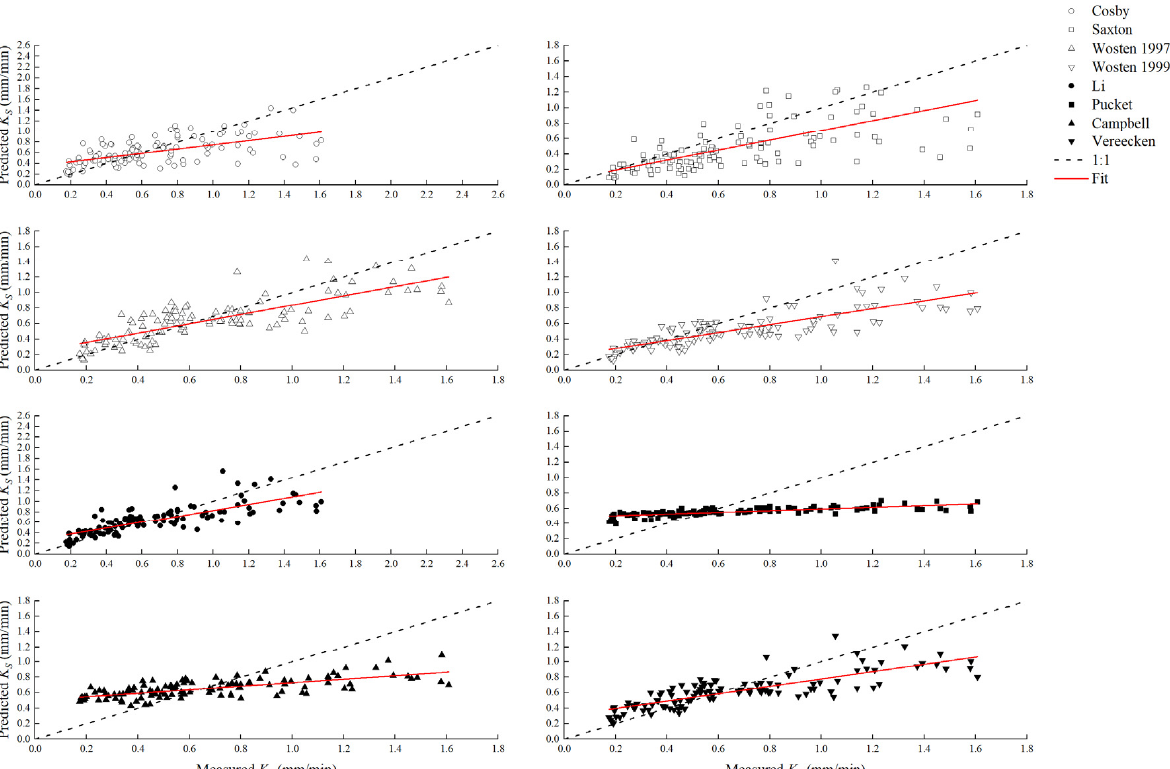
Table 5. Predictive performance of the modified